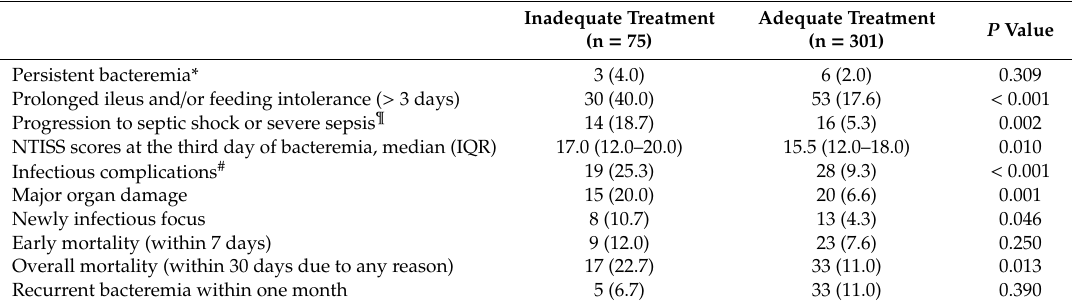
Table 3. Outcome comparisons of Gram-negative bacteremia treated with inadequate antibiotics versus adequate antibiotics.